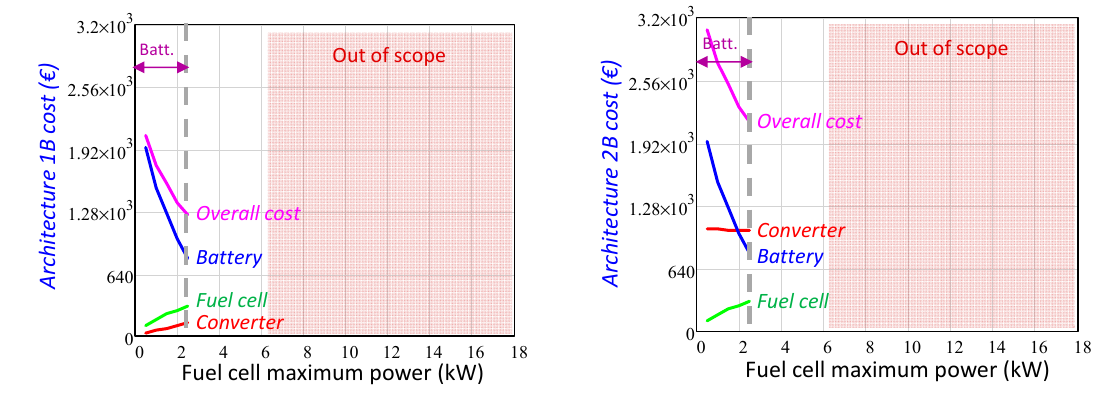
Figure 14. Architectures 1B and 2B cost.